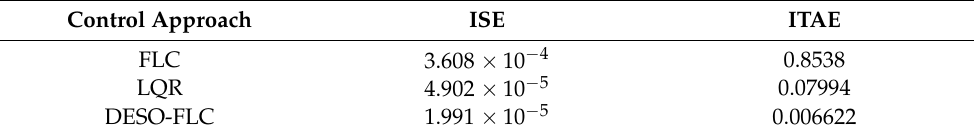
Figure 6. Response of the controlled voltage ( V C ) in the presence of the payload disturbance ( d ( t ) ). Table 3. Comparison of ISE and ITAE using various control approaches for case 1.